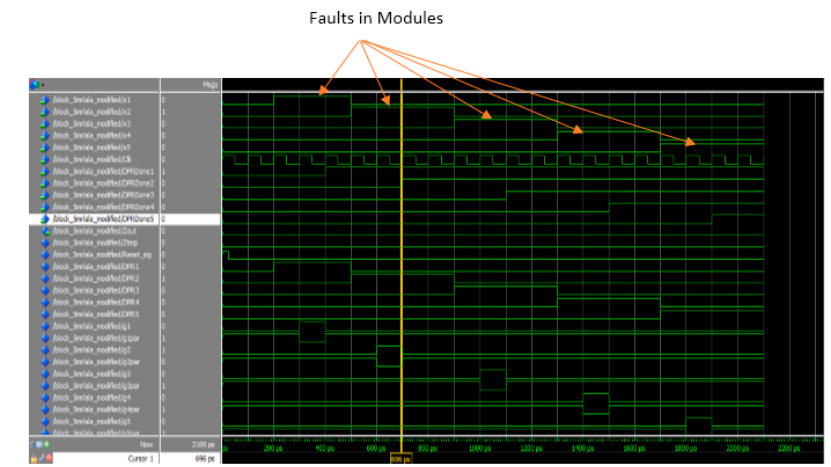
Figure 10. Simulation result from ModelSim.